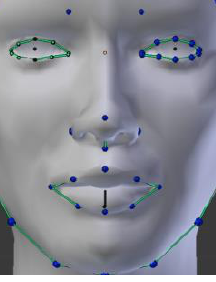
Figure 5. Set of feature points applied for 3D head model